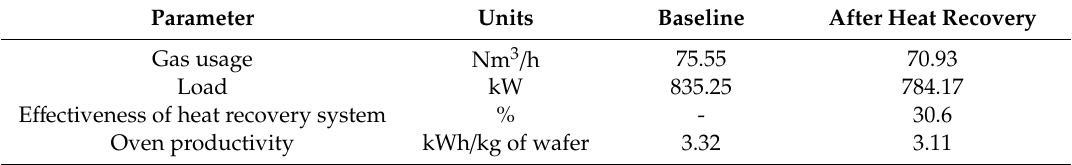
Table 12. Key performance indicators of the industrial-scale baking oven before and after heat recovery.